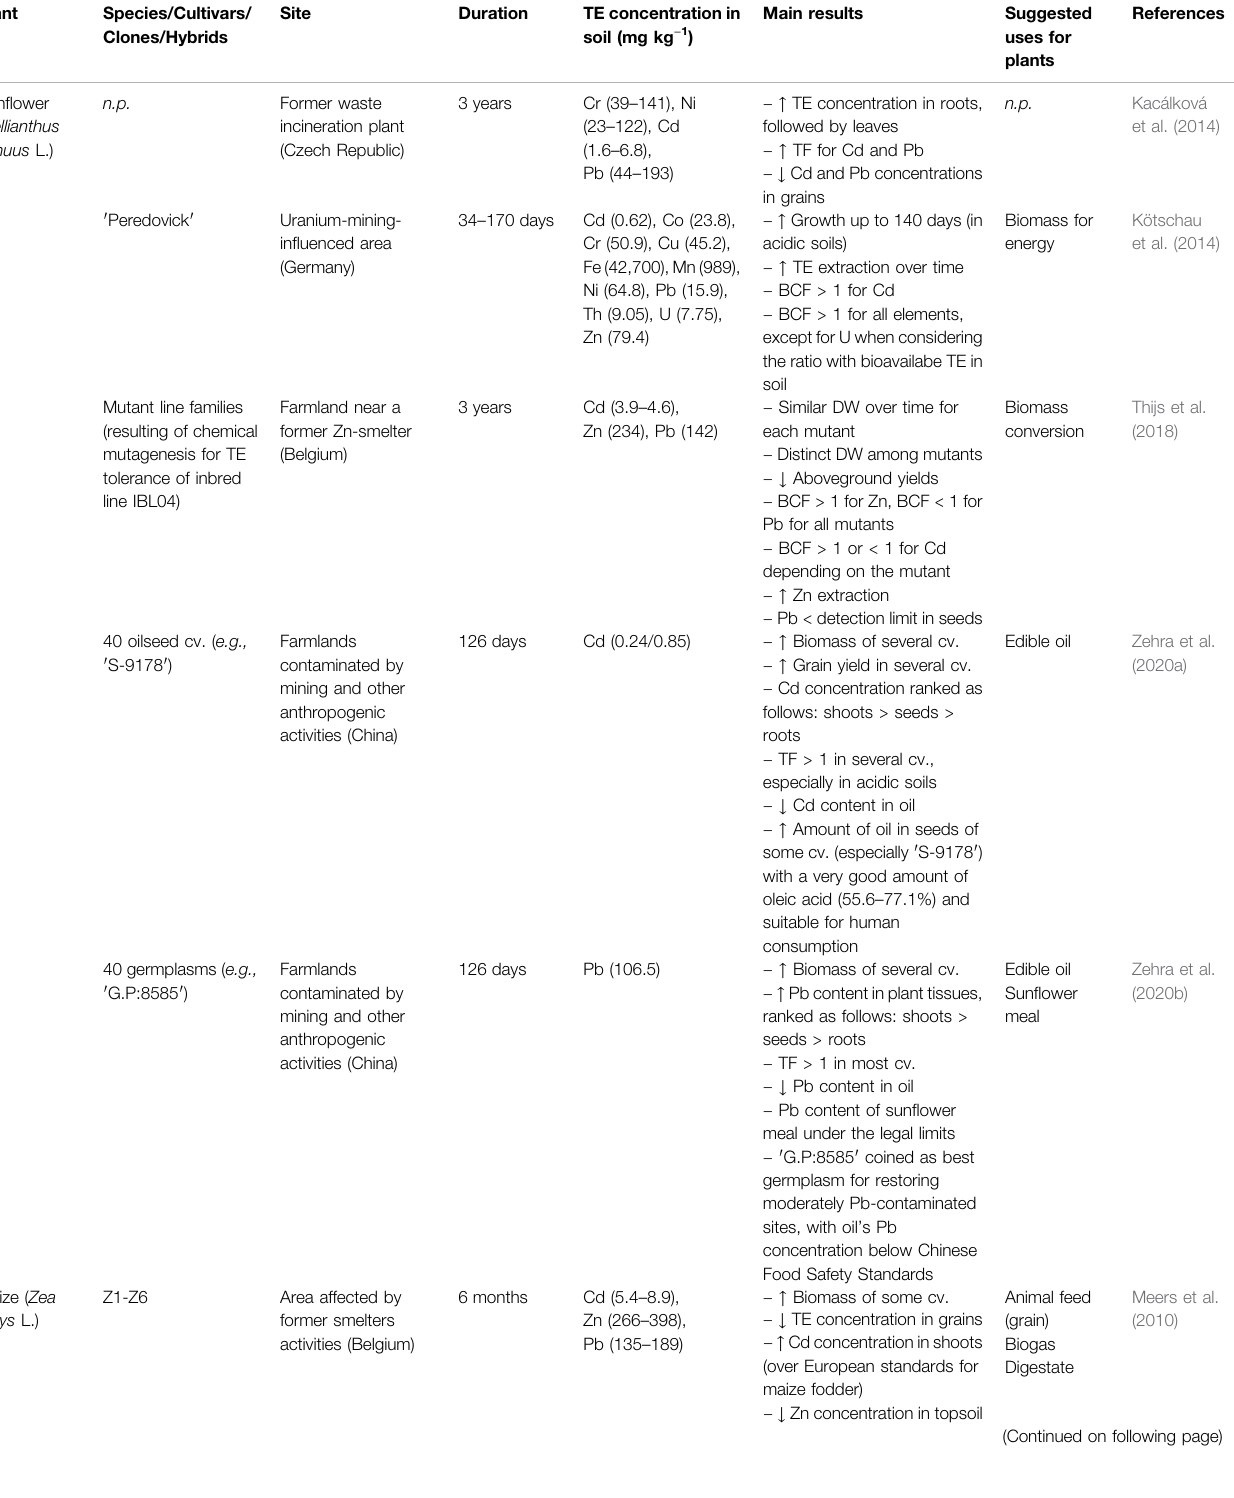
TABLE 1 | Examples of fi eld trials with economically valuable annual crops (sun fl ower, maize, tobacco). Plant Species/Cultivars/ Clones/Hybrids